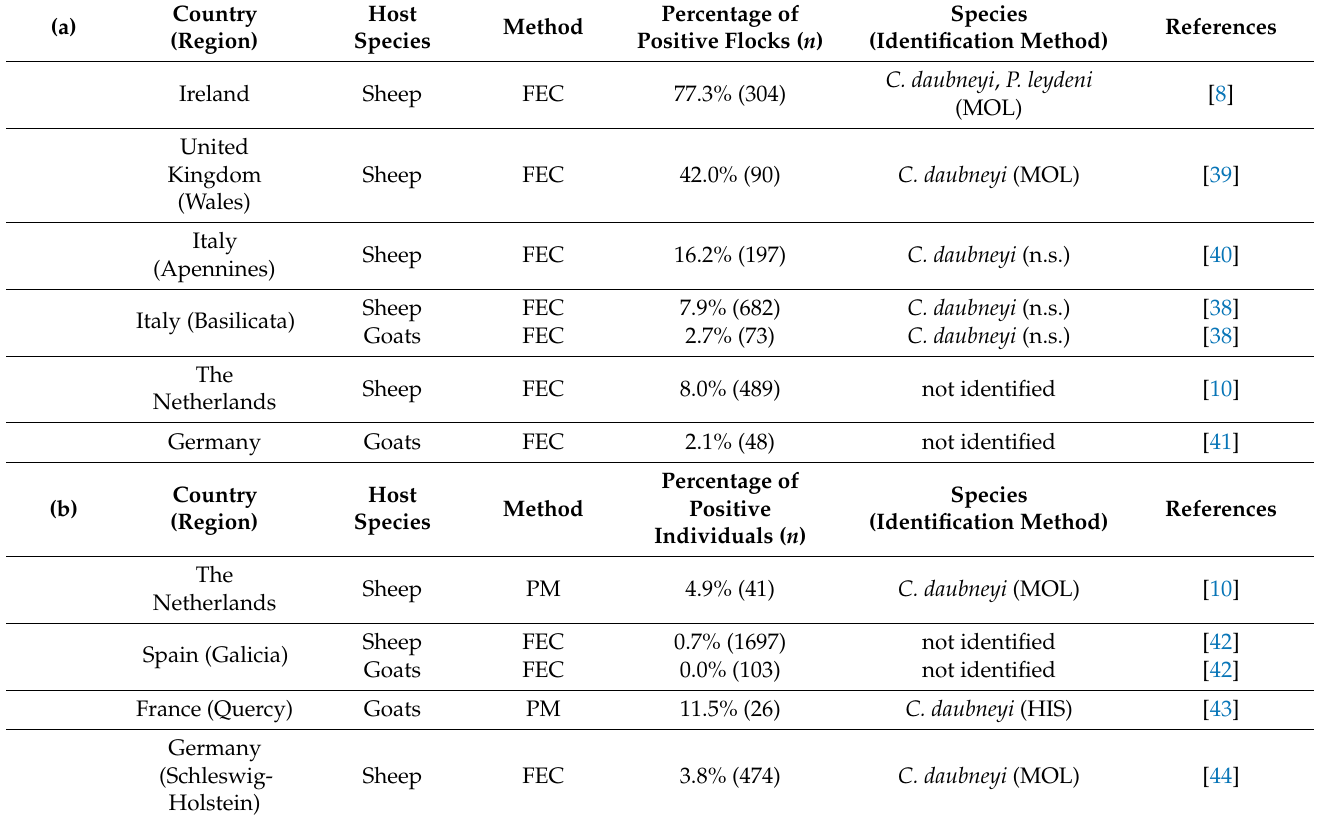
Table 1. Reported occurrence of rumen fluke infections in small ruminants in Europe specifying the number of flocks ( a ) or number of individual animals ( b ) examined, as well as the diagnostic methods used.